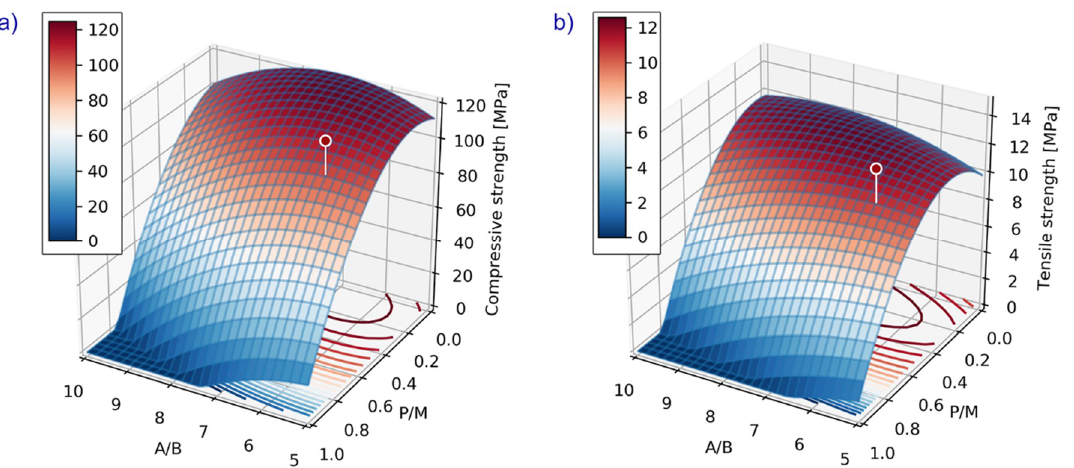
Figure 1. Compressive ( a ) and tensile ( b ) strength of concrete mix vs. the material variables x1 = A/B (aggregate to polymer binder mass ratio), x2 = P/M (waste powder to microfiller mass ratio), B/M = 0.5.